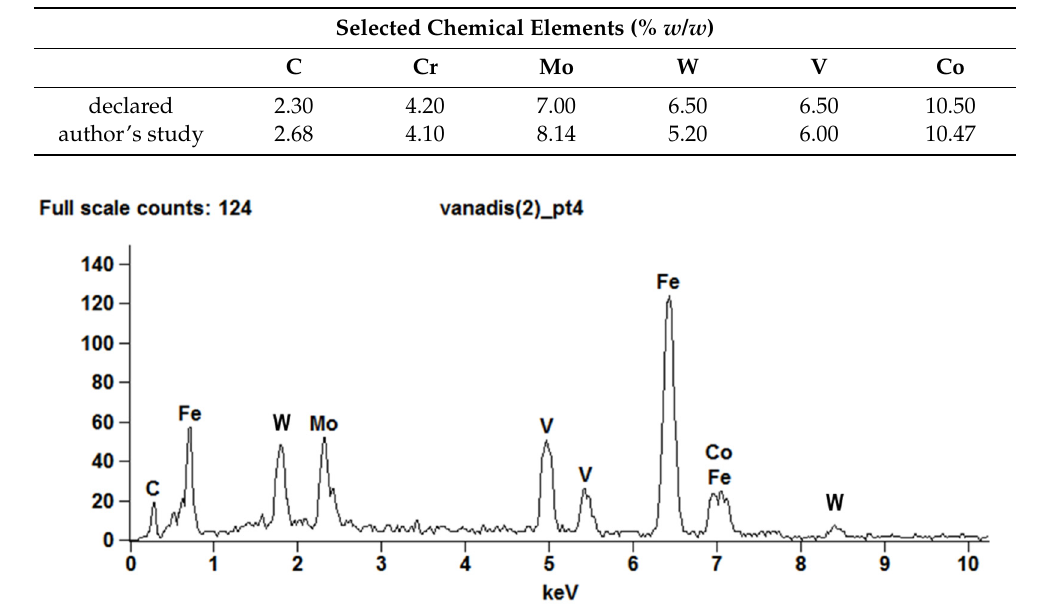
Figure 2. X ‐ ray dispersive energy spectrum of the Vanadis 60 SuperClean steel.